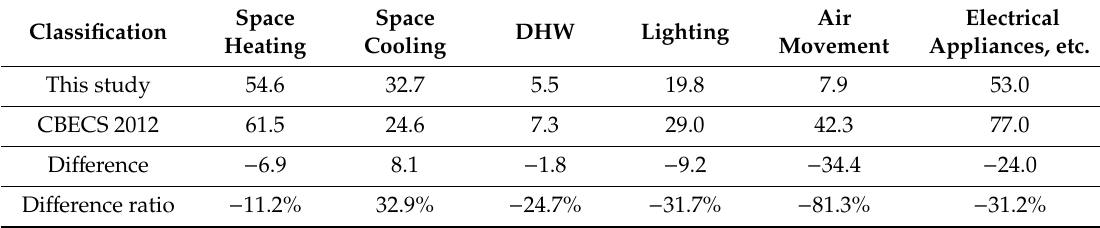
Table 17. Magnitudes of the average site end-use EUIs in this study and CBECS 2012 (kWh / m 2 ·